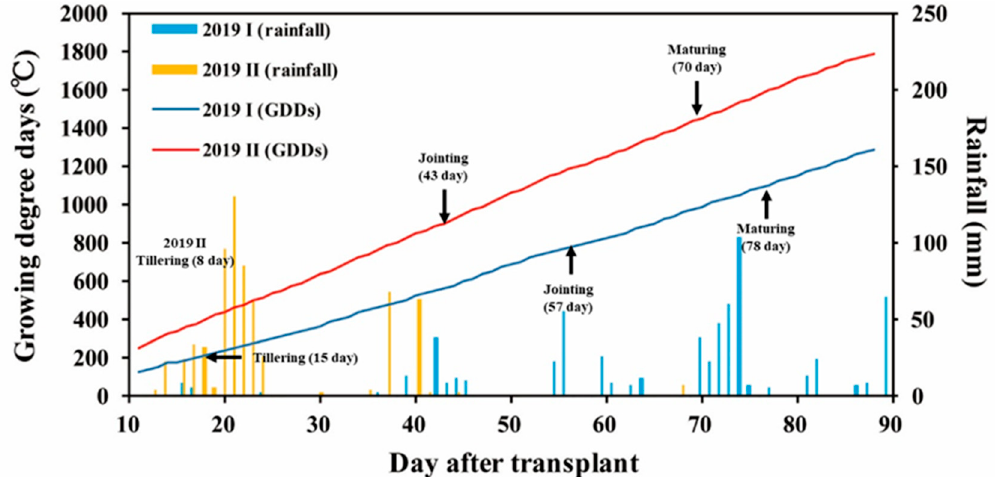
Figure 12. The growing degree days of TNG711 until panicle initiation and rainfall in the first and second crop seasons.